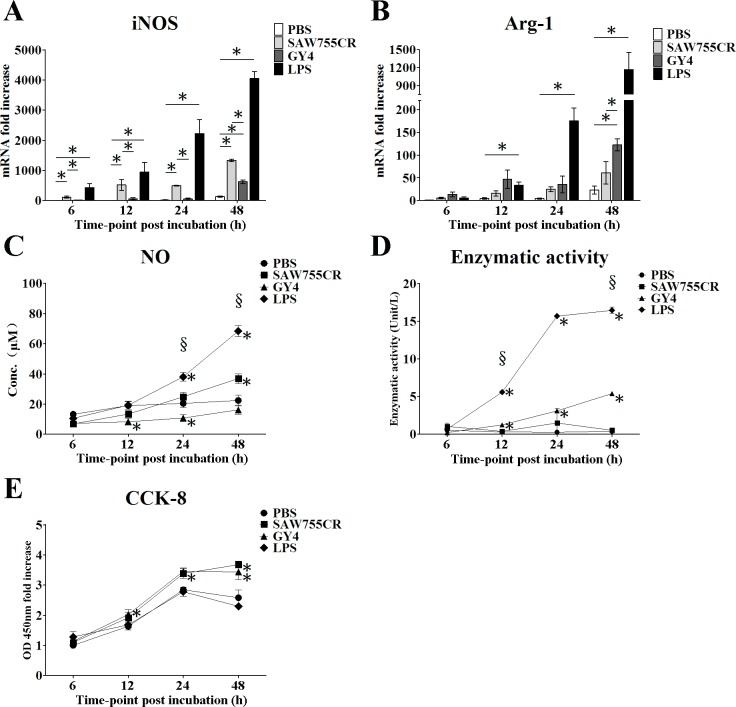
Polarization of RAW264.7 cells stimulated by trophozoite lysates in vitro.(A,B) Quantitative real-time PCR assays of iNOS and Arg-1 genes induced by PBS, trophozoite lysates or LPS in RAW264.7 cells. Expression levels of iNOS (A) and Arg-1 (B) are shown as 2-ΔΔCt for the target gene relative to β-actin and normalized with corresponding values in the PBS group. Y axes are numbers correspond to the fold increase over 1.0, assigned to the PBS group. * P < 0.05. (C) NO production in RAW264.7 cells. NO (μM) in culture supernatant of RAW264.7 cells stimulated by PBS, trophozoite lysates or LPS for 6 h, 12 h, 24 h and 48 h was measured by a Griess assay. (D) Arginase activity of RAW264.7 cells. Arginase activity (unit/L) was measured in RAW264.7 cell lysates stimulated by PBS, trophozoite lysates or LPS for 6 h, 12 h, 24 h and 48 h. (E) Cell proliferation assay of RAW264.7 cells. Cell proliferation was measured using a CCK-8 kit at 6 h, 12 h, 24 h and 48 h after stimulation with PBS, trophozoite lysates or LPS. The Y-axis shows the optical density (OD) of the test well minus the blank well. * P < 0.05 vs. PBS control in C to E, § P < 0.05 for E. nuttalli GY4 vs. E. histolytica SAW755CR in C and D.